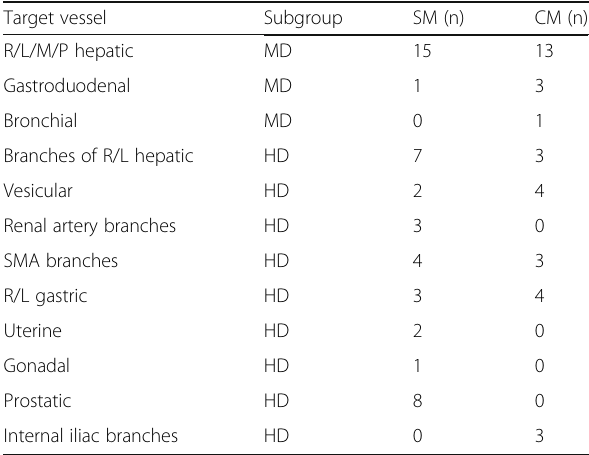
Table 1 Vessels cannulated in the SM and CM groups and their classification as either moderate-difficulty (MD) or high-difficulty (HD) Target